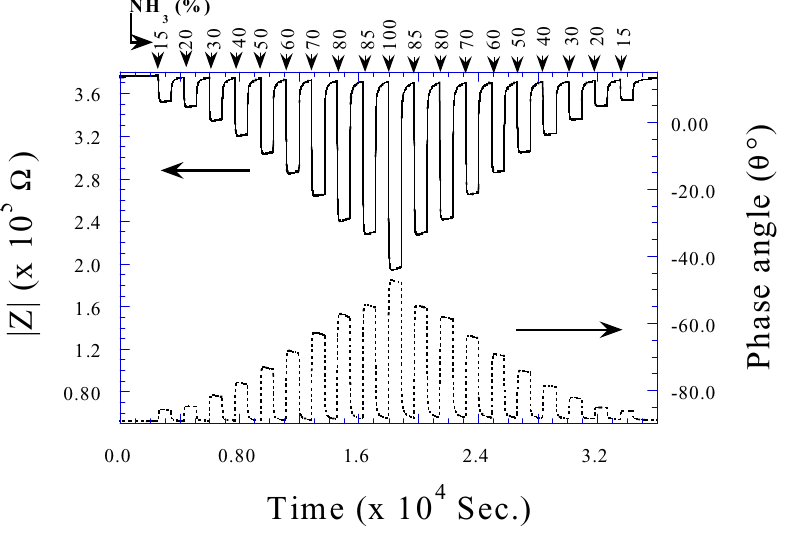
Figure 14. Change in impedance magnitude and phase of sensor DS15 in response to changing ammonia concentration. Argon is used as the carrier gas. The sensor response is completely